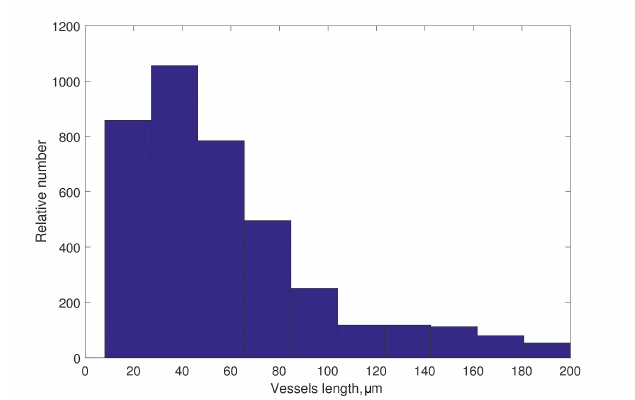
Figure 2. Blood vessels length distribution summarized from